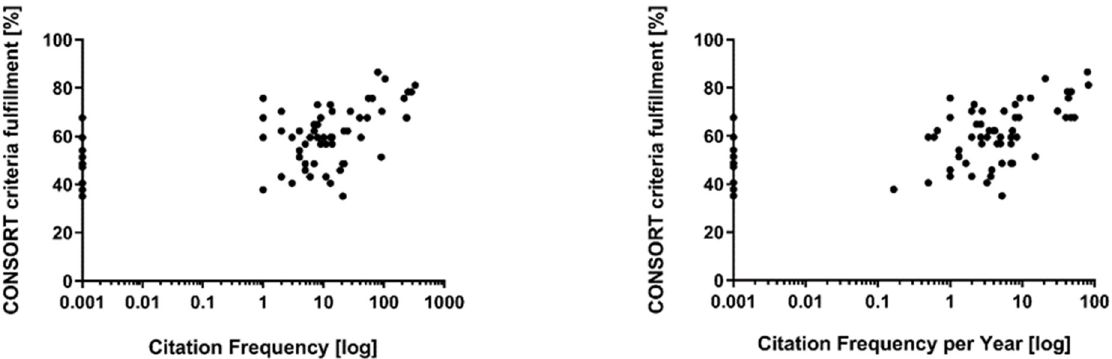
Figure 3. Correlation of citation frequency and CONSORT criteria fulfillment ( left ), citation frequency per year and CONSORT criteria fulfillment ( right ).